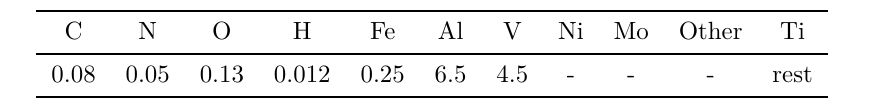
Table 3. Chemical composition of Ti6Al4V [wt %]